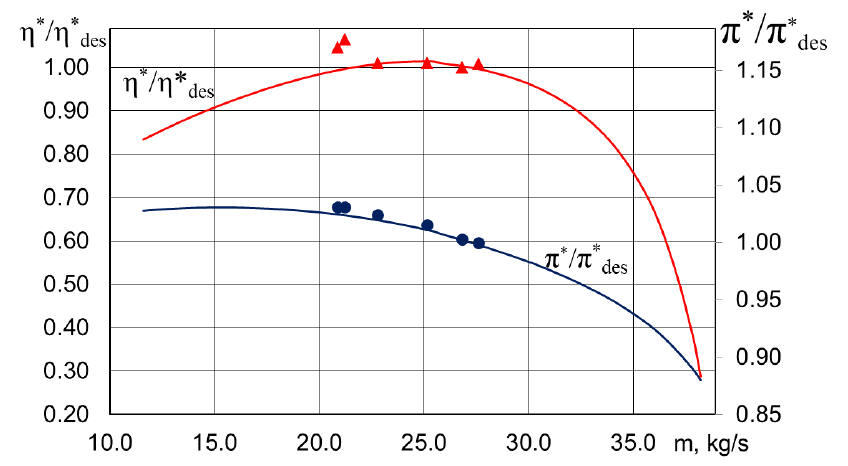
Figure 12. Design characteristics of the turbo-expander compressor and the experimental results.